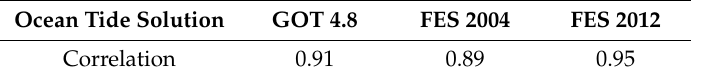
Table 9. Correlations of different tide solutions with respect to the tide gauge tide